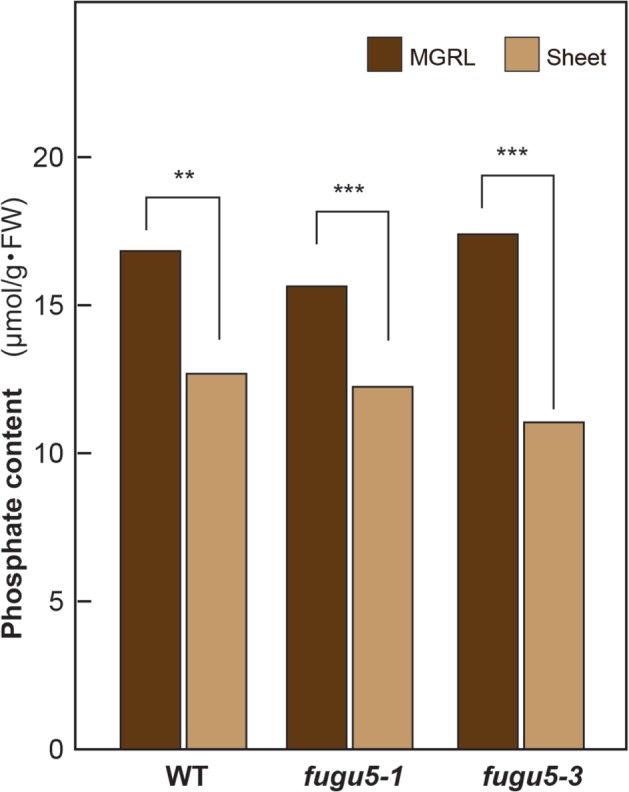
Contact of rosette leaves with the culture medium increases the phosphate contents of plant shoots. WT, fugu5-1, and fugu5-3 were cultivated on MGRL plates for 3 weeks with or without plastic sheets that prevented contact with culture medium. The phosphate contents of shoot extracts were determined as described in the Materials and Methods section. Asterisks indicate significant differences at ∗∗P < 0.01 and ∗∗∗P < 0.005 compared with plants grown without plastic sheets (Student’s t-test; n ≥3).